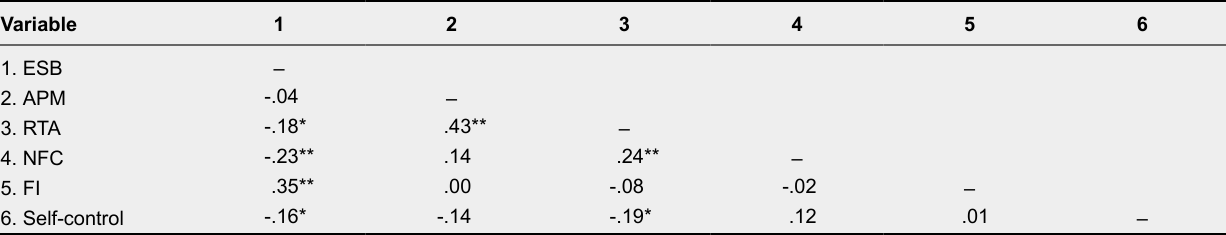
Correlation Coefficients Between the Assessed Variables Variable